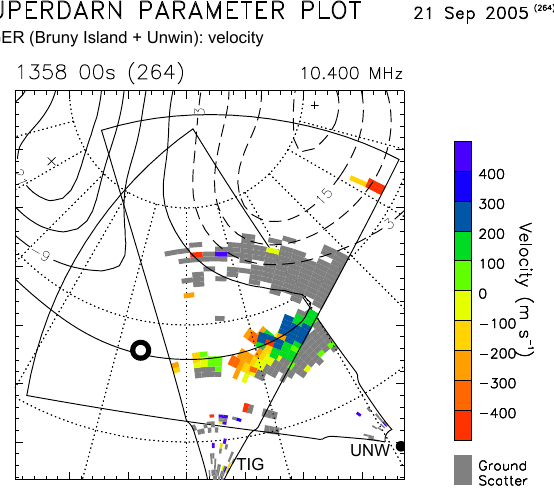
Fig. 3. A Line of sight velocity plot from the two TIGER South- ern Hemisphere SuperDARN radars in AACGM Geomagnetic Lat- itude/Magnetic Local Time coordinates. The coloured squares rep- resent plasma velocity, with positive velocity towards the radar and vice versa. Overlaid are equipotential contours showing the iono- spheric convection pattern, as predicted by the map-potential tech- nique. The T96 footpoint of the Cluster spacecraft is marked by the black circle.